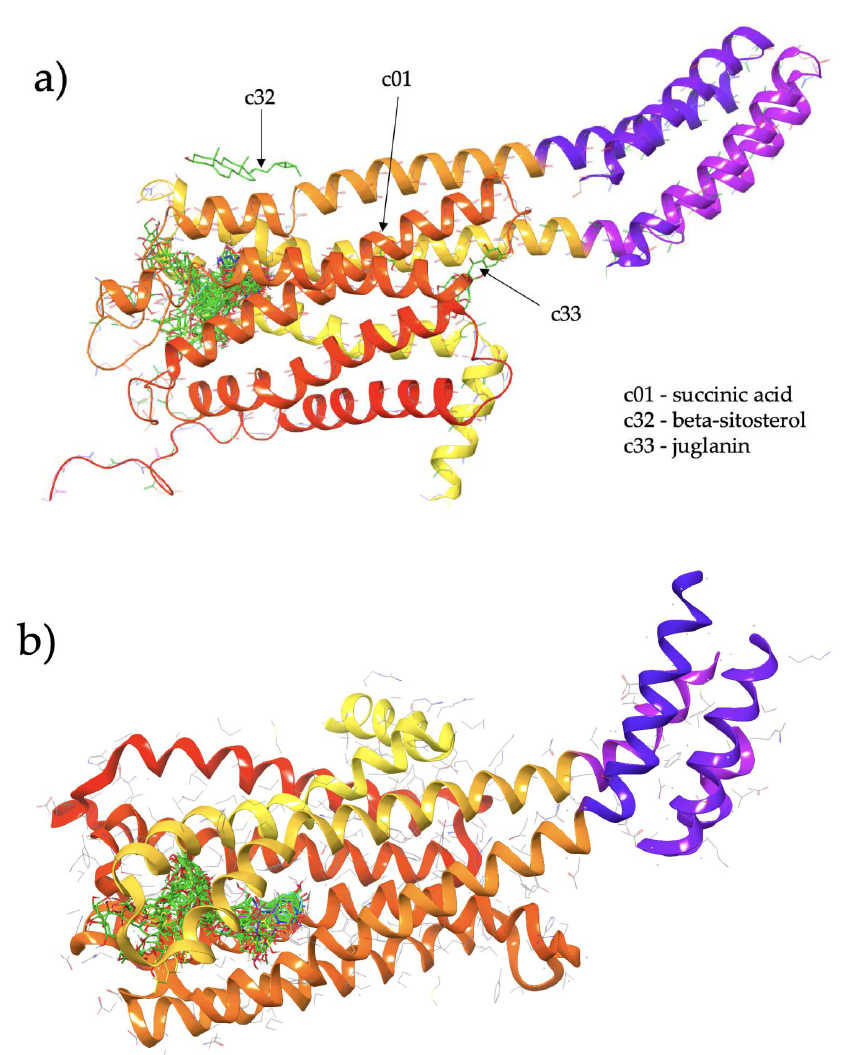
Figure 1. ( a ) Cluster of Cassiae semen ligands binding to structure S1 (5-HT2C in an agonist-bound active conformation; chain A of PDBID: 6BQG). ( b ) Cluster of Cassiae semen ligands binding to structure S2 (5-HT2C in an antagonist-bound inactive conformation; chain A of PDBID: 6BQH).